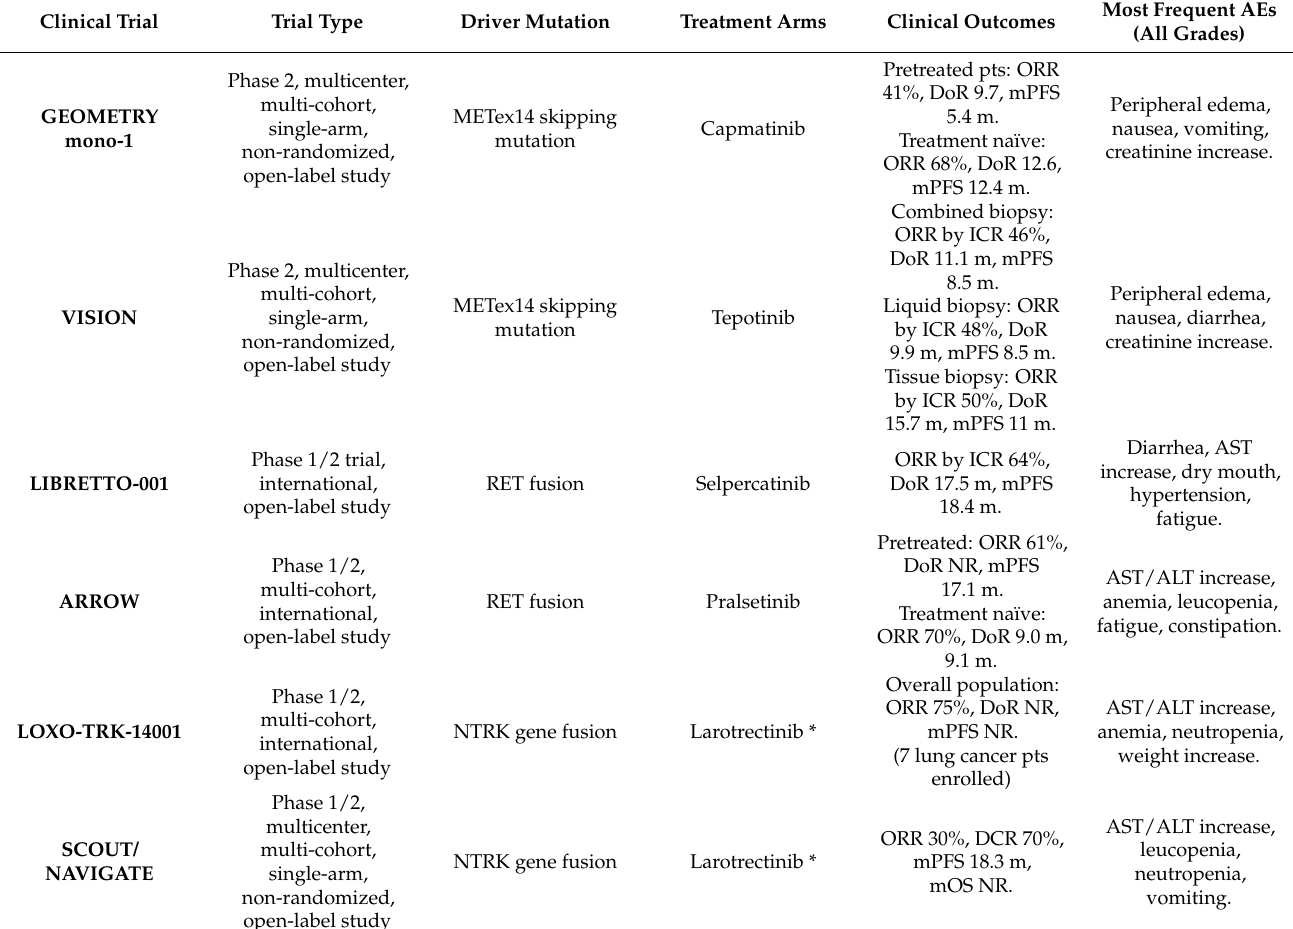
Table 1. Clinical activity of currently FDA approved targeted